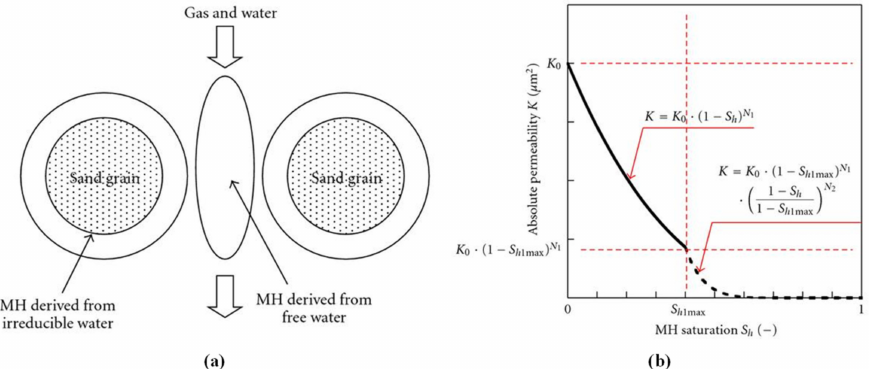
Figure 4. ( a ) Schematic diagram of hydrate two-component system; ( b ) formulation of permeability as a function of hydrate saturation in the two-component system. All rights reserved [50].